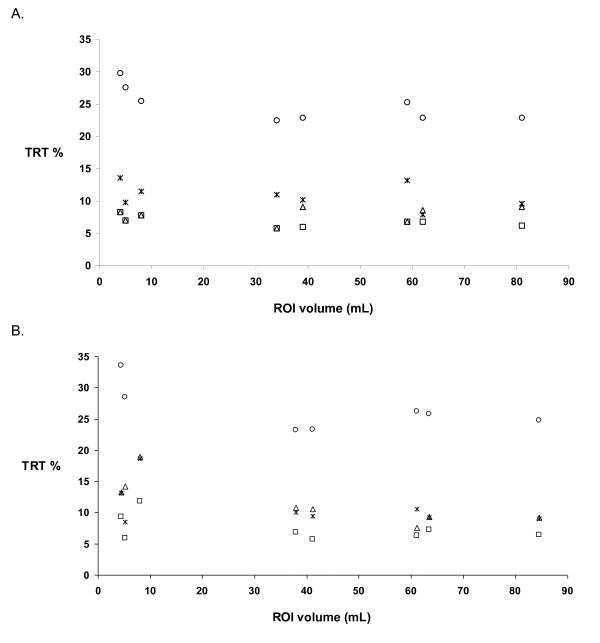
Test-retest variability (TRT %) as a function of ROI volume. (A) FBP reconstructed data and (B) PVC OSEM reconstructed data. Squares, 1T2k60 model with outcome measure VT; triangles, 1T2k10 model with outcome measure K1; circles, 2T4kVTnsfix model with outcome measure BPND; crosses, 2T4kVTnsfix model with outcome measure VT.